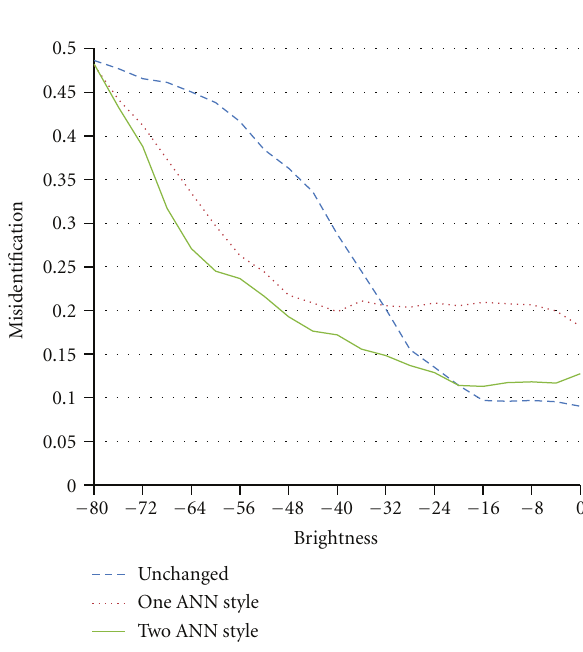
Figure 10: False rejection rate and false acceptance rate.